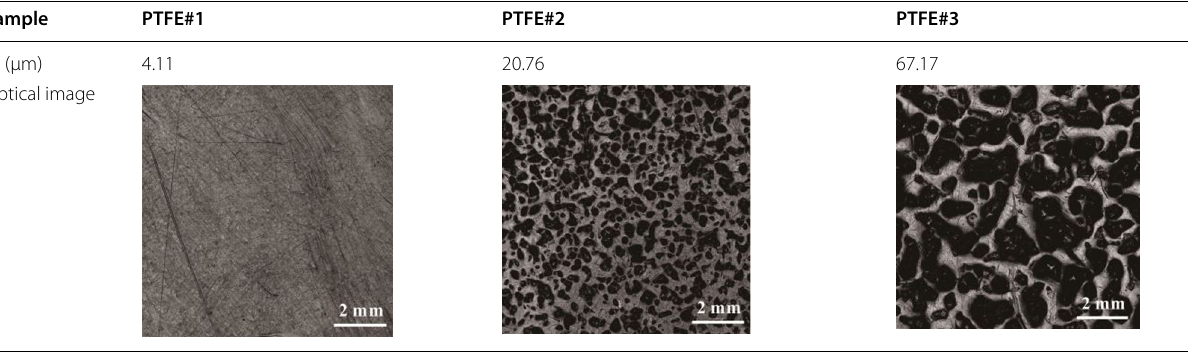
Table 2 Information on PTFE samples including surface roughness S